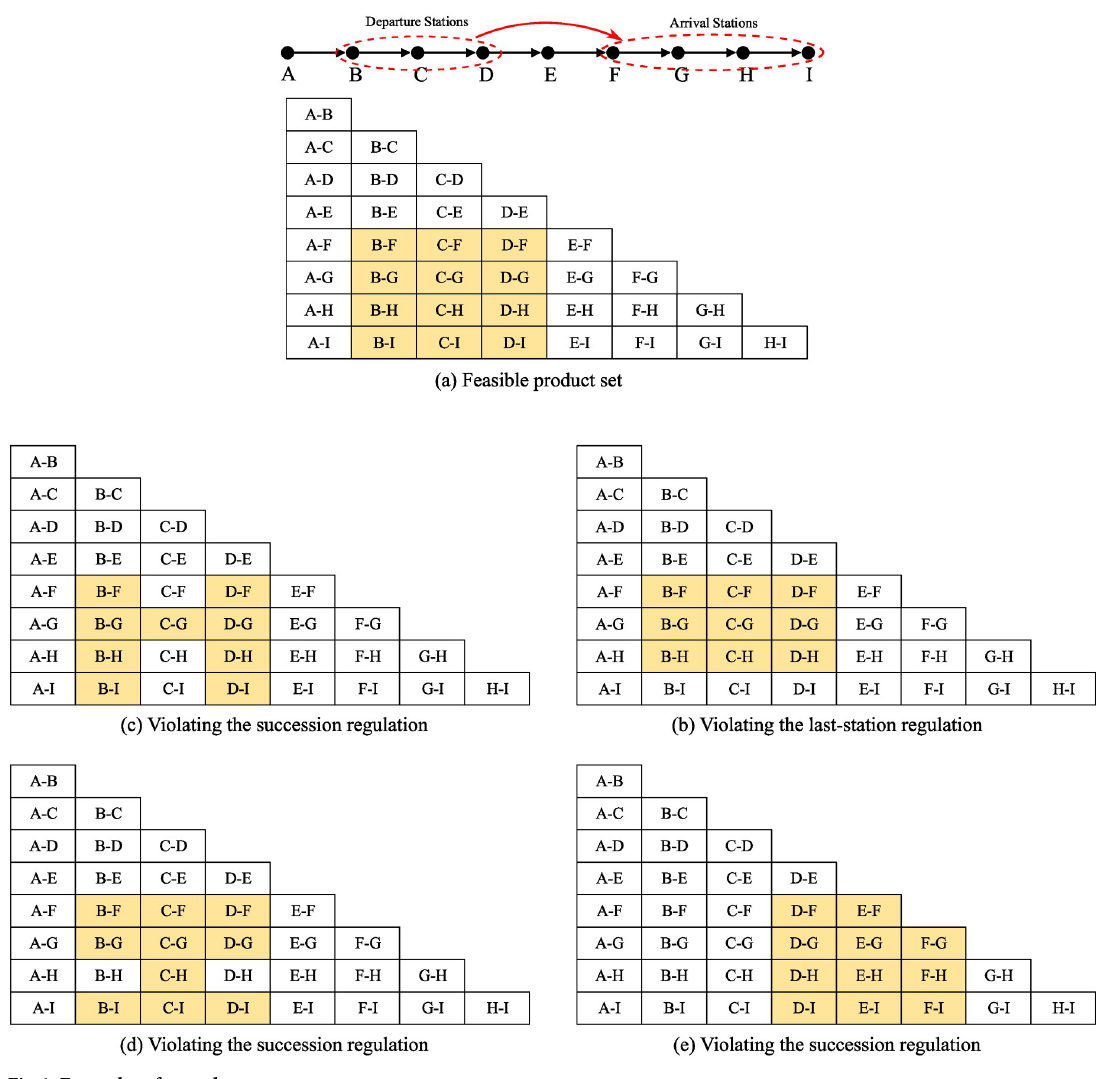
Fig 6. Examples of a product